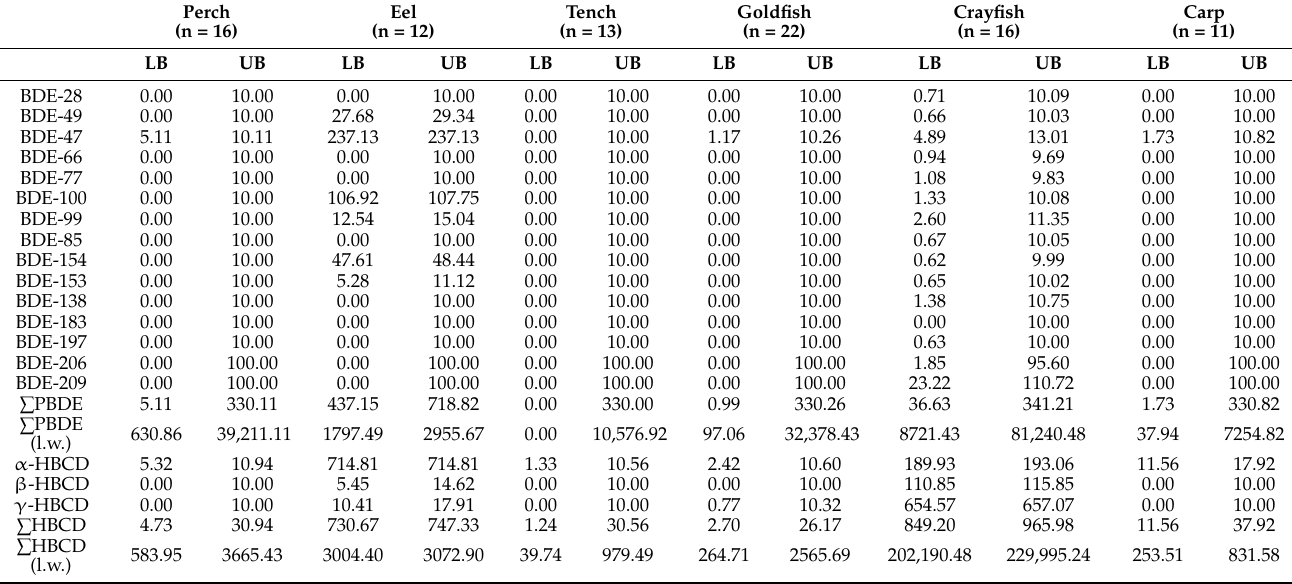
Figure 2. Congeners’ representativeness among different species. The average PBDEs’ and HBCDs’ LB and UB concentrations in each species considered are shown in Table 1 (detailed data are shown in Table S1a,b). The concentrations of PBDEs and HBCDs are expressed in pg/g wet weight (w.w.); values of ∑ PBDE and ∑ HBCDs are also expressed in pg/g l.w. (lipid weight) for a better comparison of obtained data with similar results. The ∑ PBDE calculated in LB and UB mode was 5.11 and 330.11 pg/g for perch, 437.15 and 718.82 pg/g for eel, 0.00 and 330.00 pg/g for tench, 0.99 and 330.26 pg/g for goldfish, 36.63 and 341.21 pg/g for crayfish and 1.73 and 330.82 pg/g for carp, for LB and UB, respectively. Concerning ∑ HBCD, the values ranged from 4.73 to 30.94 pg/g for perch, 730.67 to 747.33 pg/g for eel, 1.24 to 30.56 pg/g for tench, 2.70 to 26.17 pg/g for goldfish, 849.20 to 965.98 pg/g for crayfish and 11.56 to 37.92 pg/g for carp, for LB and UB, respectively. Table 1. Average LB and UB values (pg/g) of all investigated PBDE and HBCD congeners for the freshwater species of Lake Trasimeno.